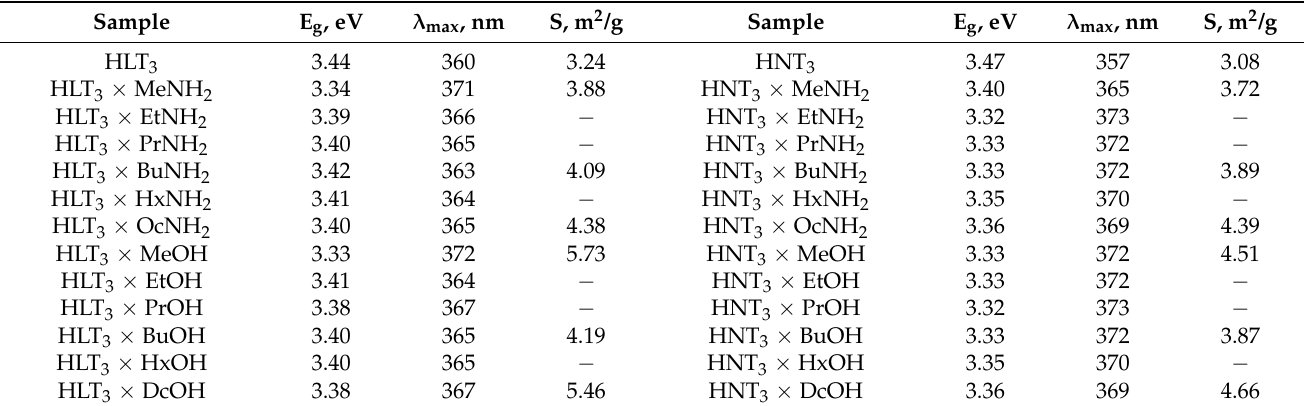
Table 3. Light absorption characteristics and specific surface area of the